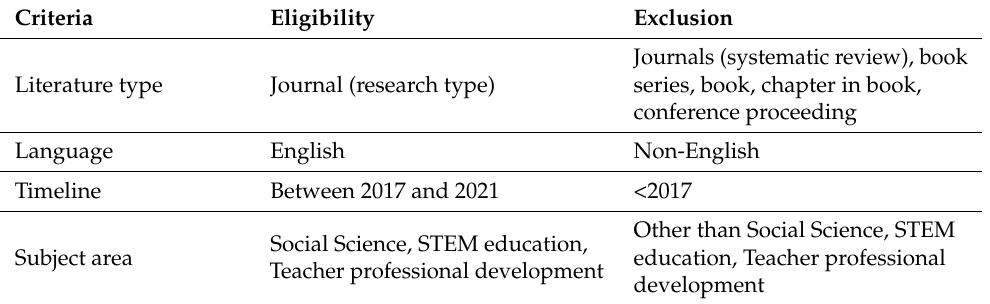
Table 2. The inclusion and exclusion